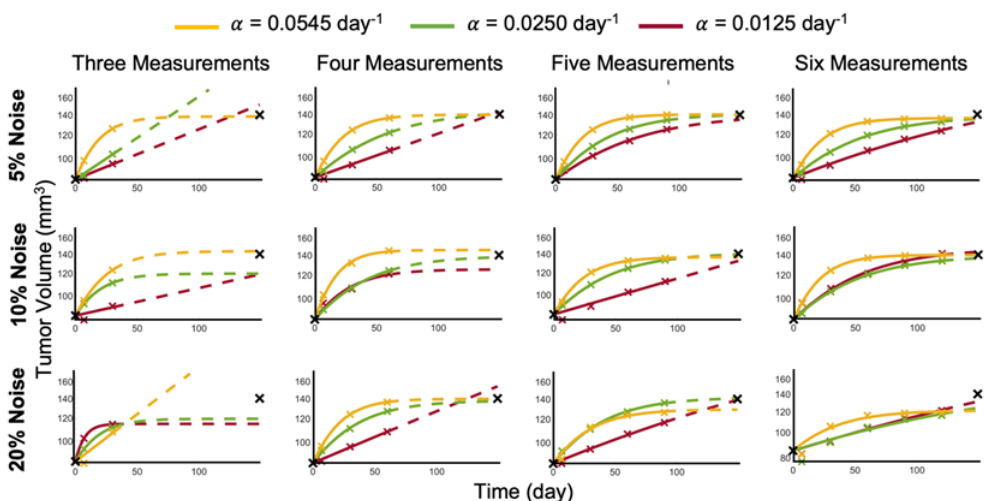
Figure 4. Logistic growth training (solid curves) and predictions (dashed curves) for Patient 9 with different percent noise in the training data.